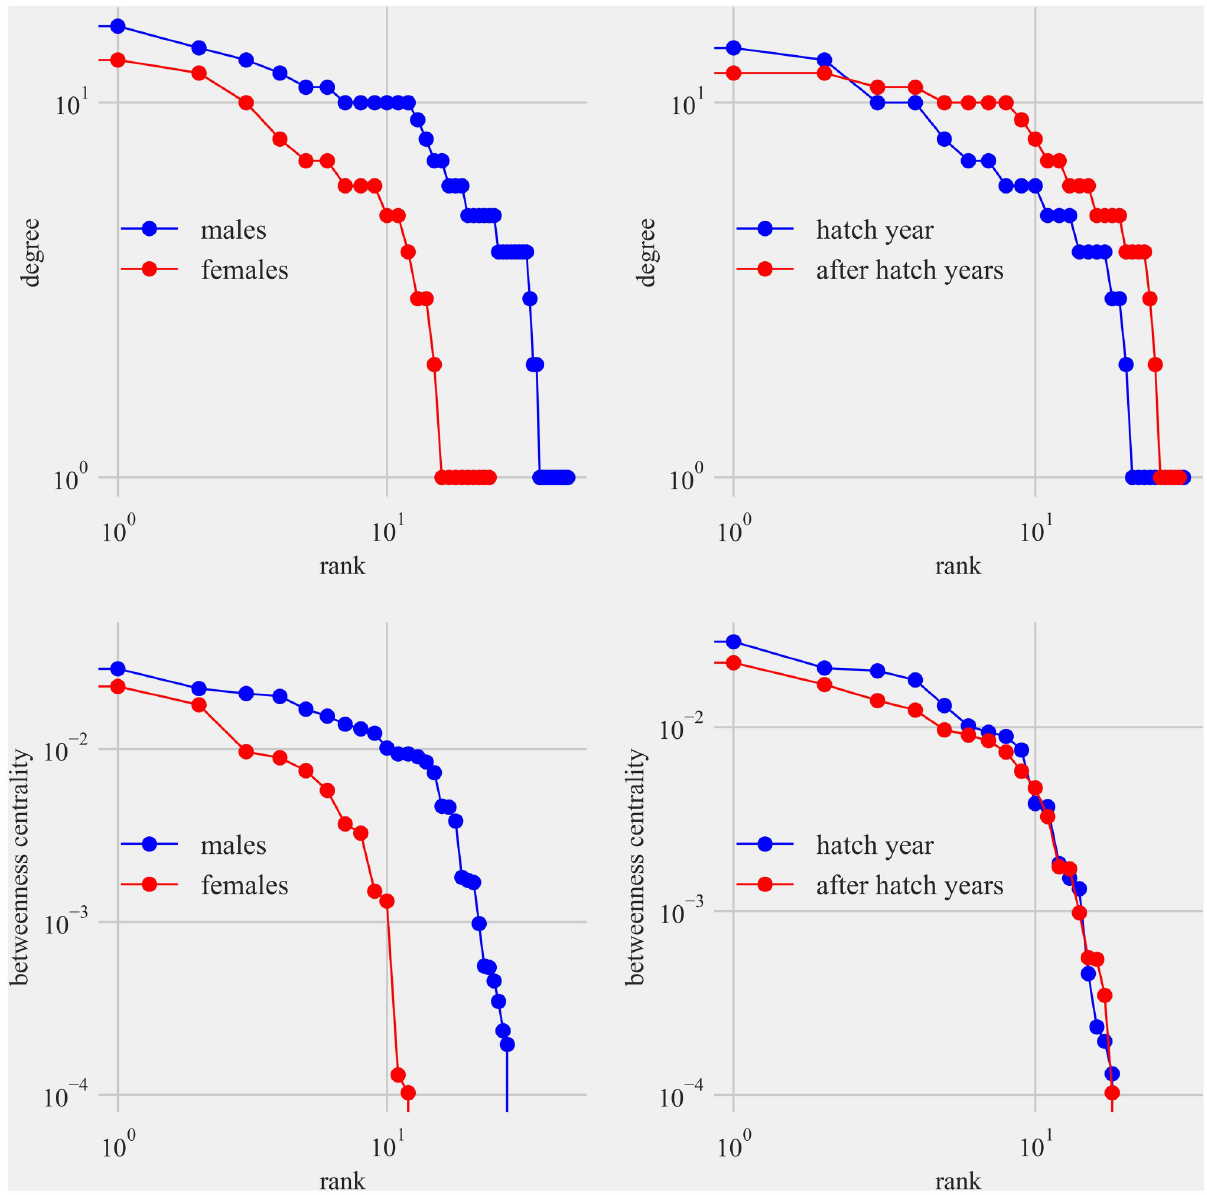
Fig 11. The degree centrality and betweenness centrality of Anna’s hummingbirds shown in two plots at the top and Allen’s hummingbirds at the bottom by sex with the male curve in blue and female curve in red and hatch year in blue and after-hatch year in red. Note that the curves of the betweenness centrality between sexes and two age classes are parallel and not spaced far apart. The distribution of centrality measures of the network (degree and betweenness centrality) showed no significant difference between age and sex of the bird ( p >